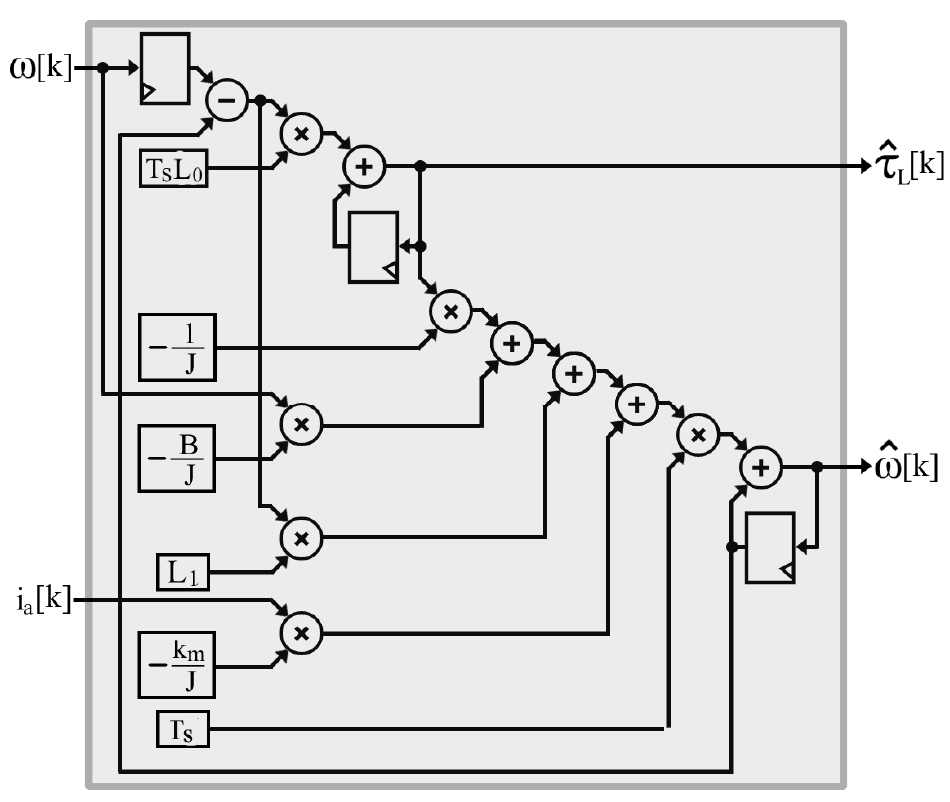
Figure 11. Implementation of the GPI observer module that estimates the load torque.